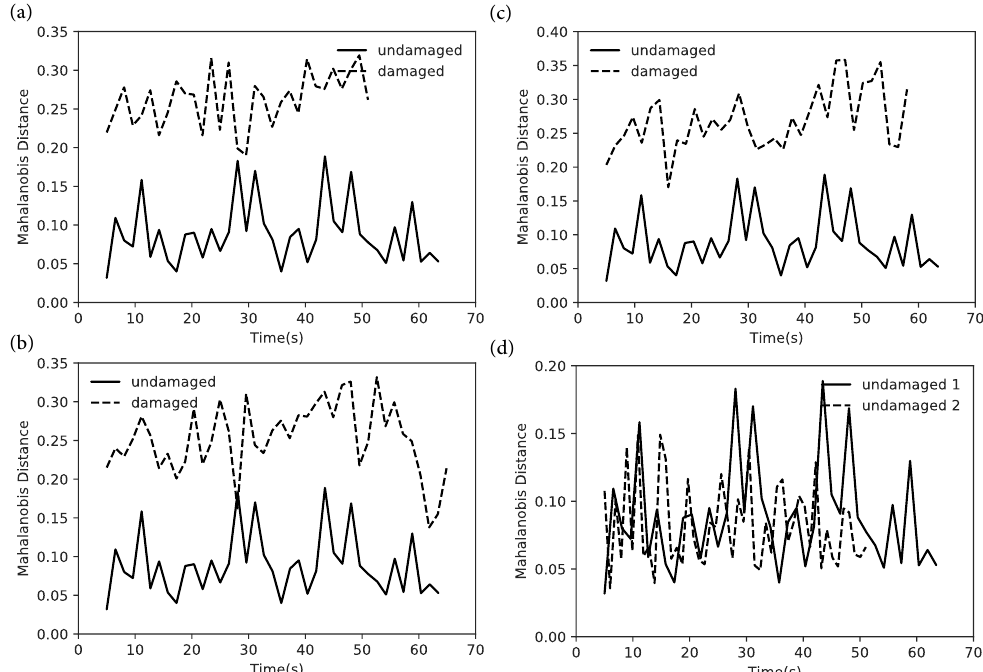
Figure 7. Change in Mahalanobis distance between the feature vectors of the damaged and undam- aged states in experimental cases with surfaces: ( a ) Sandpaper, ( b ) plastic, and ( c ) wood. Mahalanobis distance comparison of the undamaged cases for wood and plastic is shown in ( d